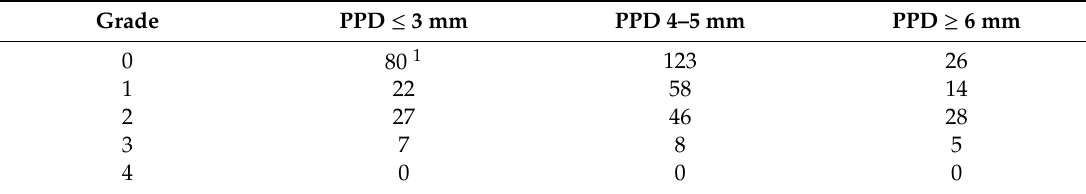
Table 2. Di ff erences in DSWMH grade according to periodontal